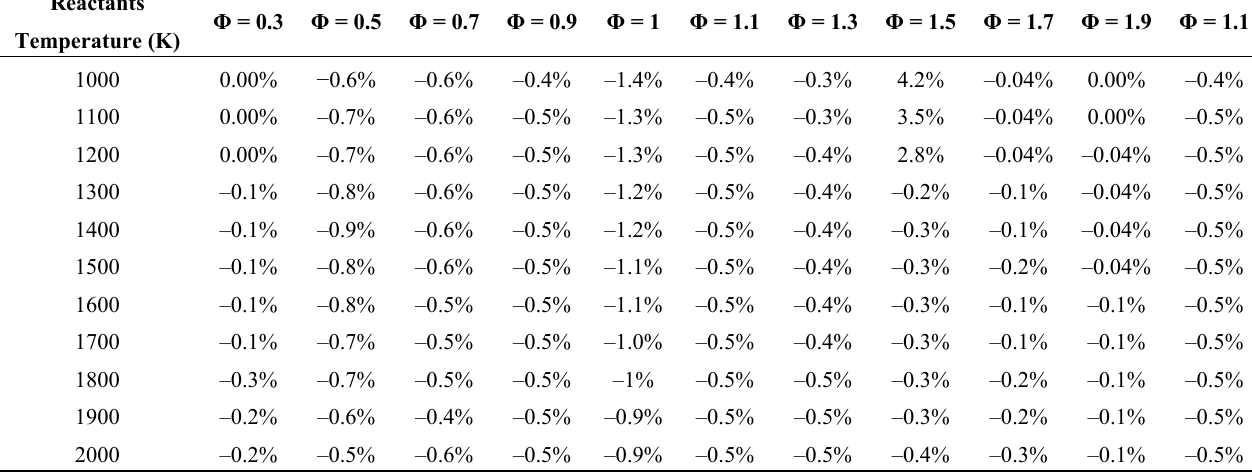
Table 2. Final Temperature % difference between GRIMech3.0 and